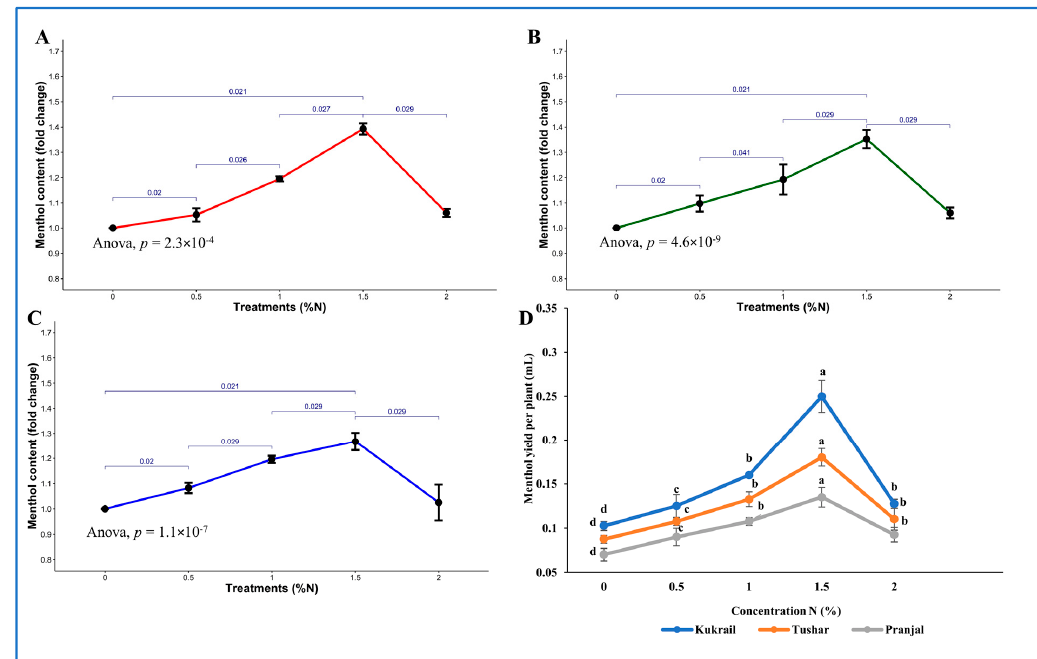
Figure 5. Effect of N on the menthol content of three cultivars. ( A ) Kukrail, ( B ) Tushar, ( C ) Pranjal, ( D ) Effect of N on the menthol yield of three peppermint cultivars.